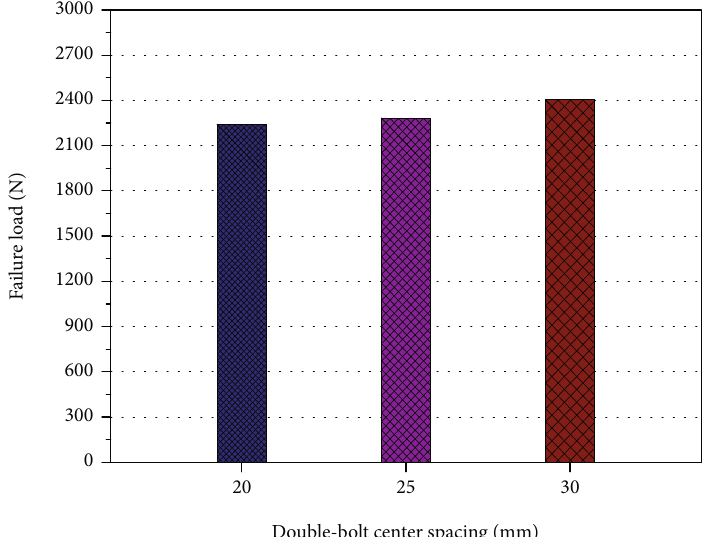
Figure 14: Variation of the failure load with double-bolt center spacing for the studied CMC/superalloy double bolted joint at 750 °